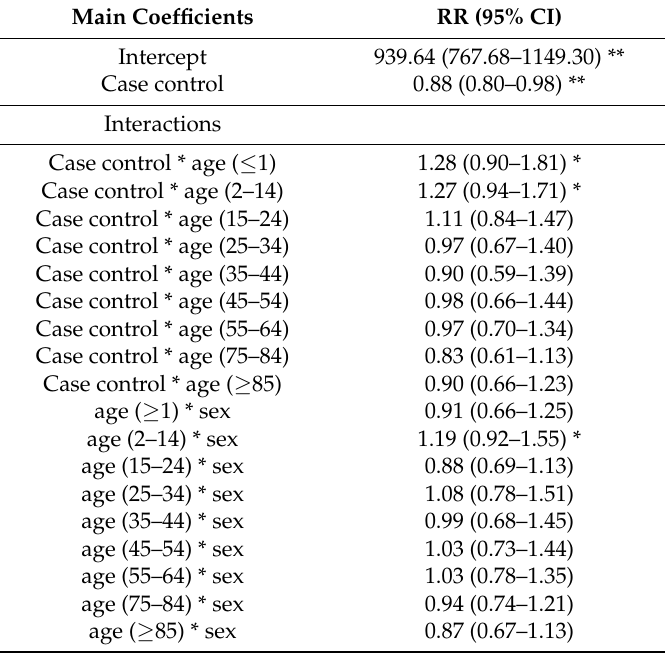
Table 3. First case-control study (non-resident vs. resident patients treated at the Palam ó s Regional Public